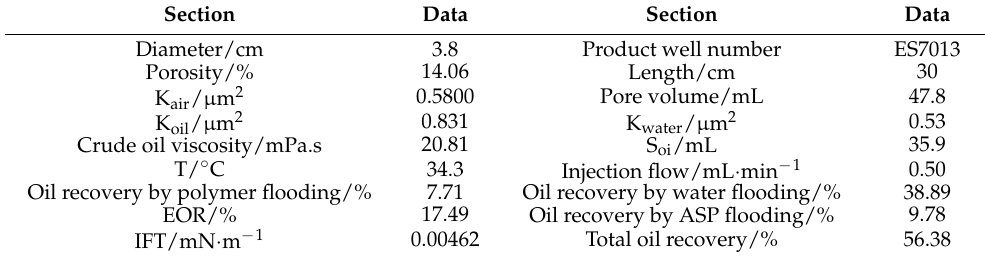
Table 4. Experiment of ASP flooding after polymer flooding.